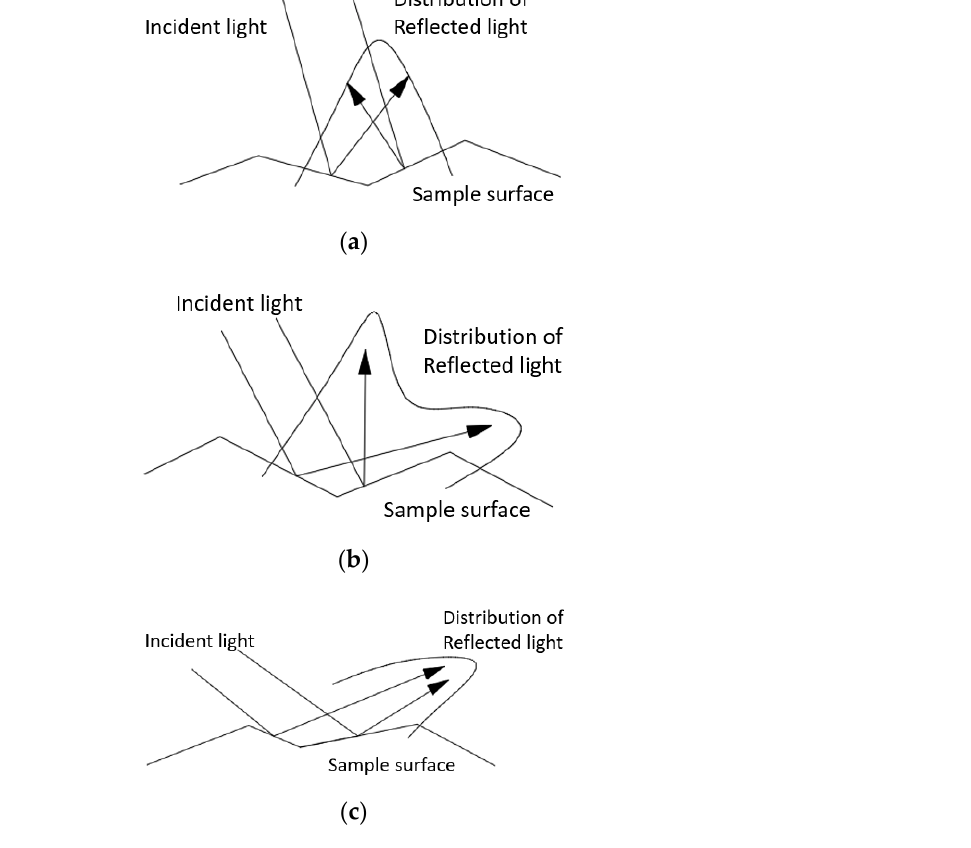
Figure 6. Reflected light distribution under different reflection situations. ( a ) Small angle of incidence; ( b ) medium and large angles of incidence; ( c ) large angle of incidence.